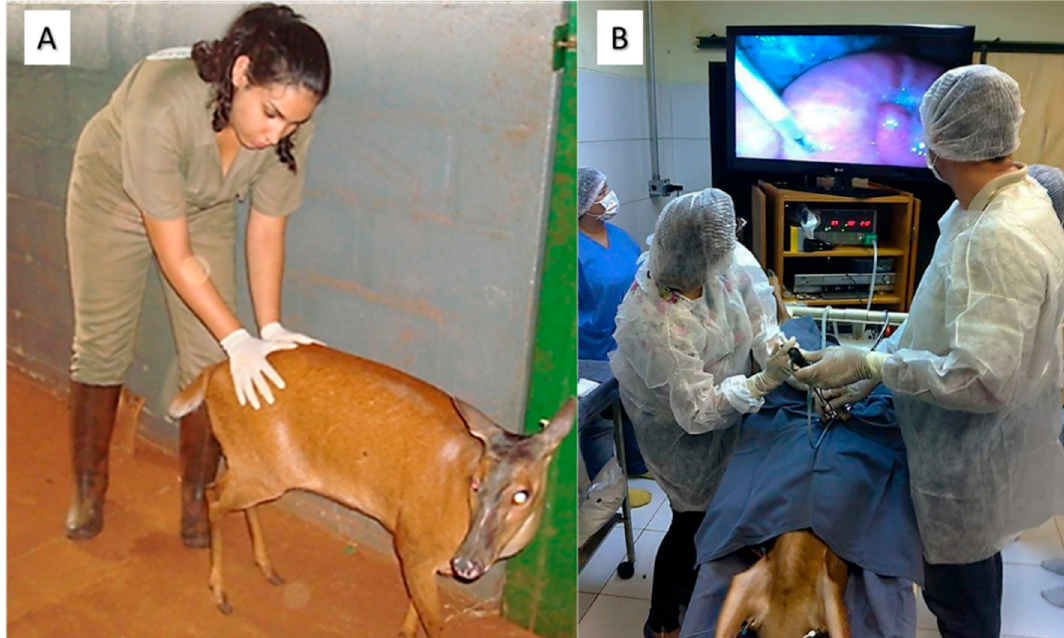
Figure 3. ( A ) M. americana female showing lordosis after having her posterior region manipulated by handler. ( B ) Artificial insemination by video-laparoscopy in M. americana .